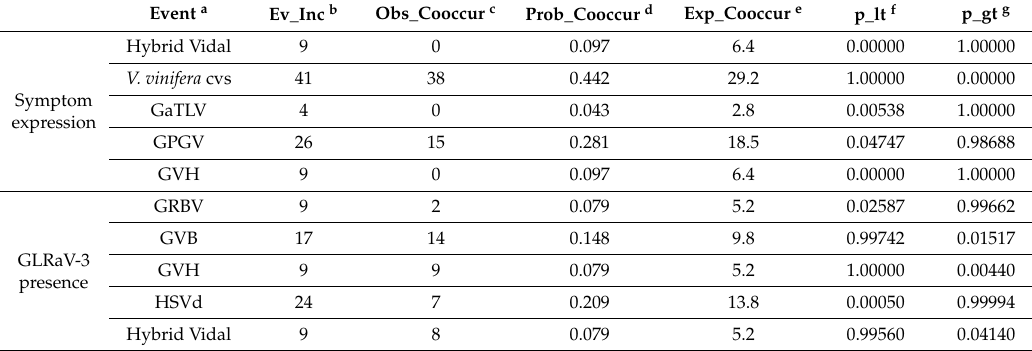
Table 2. Co-occurrence table displaying the events that are significantly associated with leafroll-like symptom development and presence of grapevine leafroll-associated virus 3 (GLRaV-3).